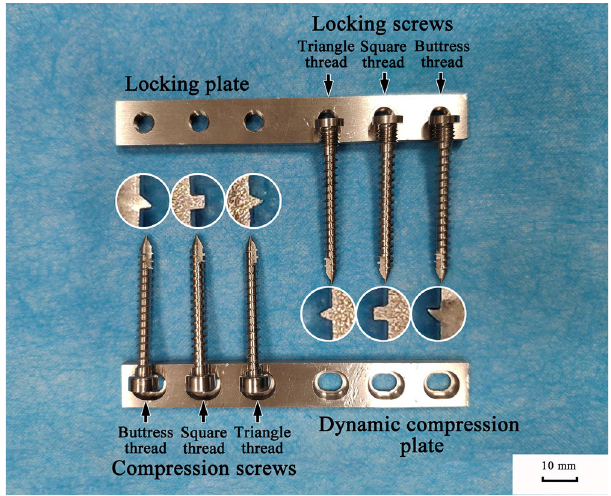
Figure 1. Screws and corresponding plates for the biomechanical tests in this